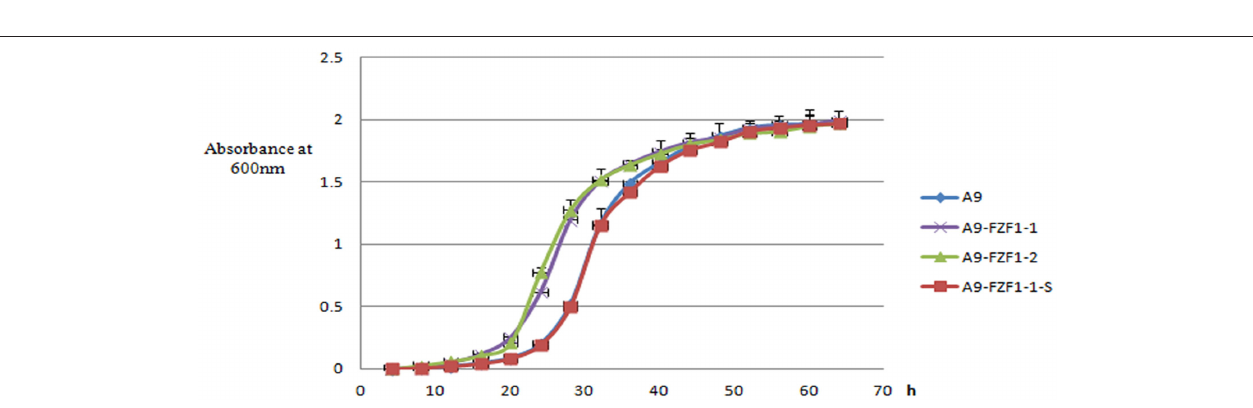
FIGURE 2 | The expression level of the FZF1 (A) and SSU1 (B) genes in different strains. The expression levels of genes were assessed using a 2 − 11 C T method to determine the relative gene expression from qPCR data with ACT1 as a housekeeping gene. Values are 2 − 11 C T Mean ± SE ( n = 3). NS: P > 0.05, not significant, ** P < 0.01, with one-way ANOVA. Note that different scales are used in the two figures. Total RNA failed to be extracted from A9-FZF1-u-d after treatment with sulfite, so the data of A9-FZF1-u-d were absent.